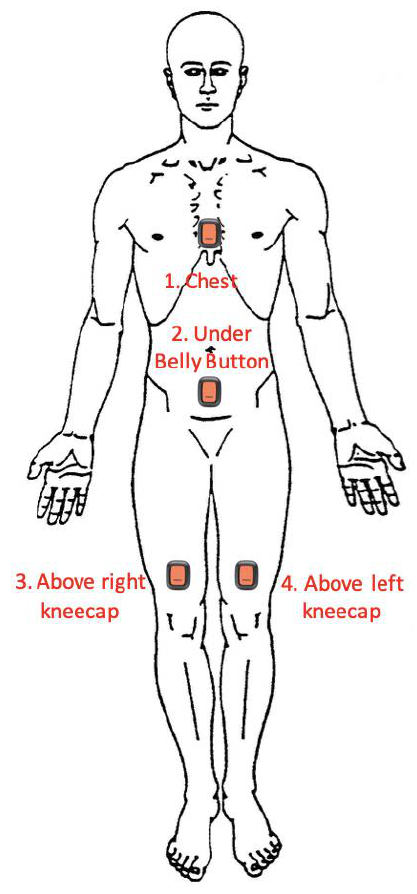
Figure 1. Locations of XSENS DOT Placement on Participants.